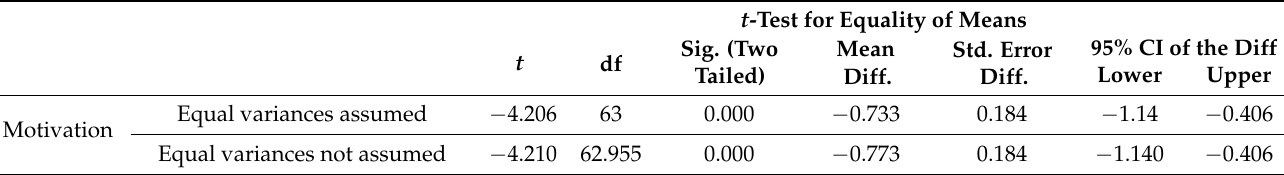
Table 7. Results of the t -test about student motivation and learning